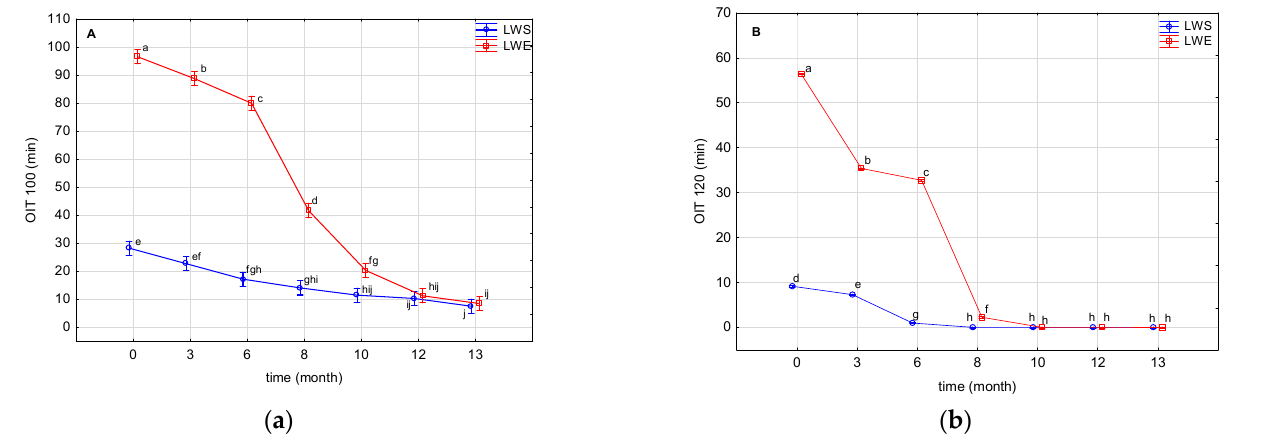
Figure 2. DSC OIT results for lipids extracted from the standard wafers (LWS) and wafers with extract (LWE) during 13 months of storage. ( a ) DSC OIT index measured at 100 °C ( b ) DSC OIT index measured at 120 °C. Vertical bars indicate 0.95 confidence intervals, the same letters indicate lack of significant differences between data ( α = 0.05).